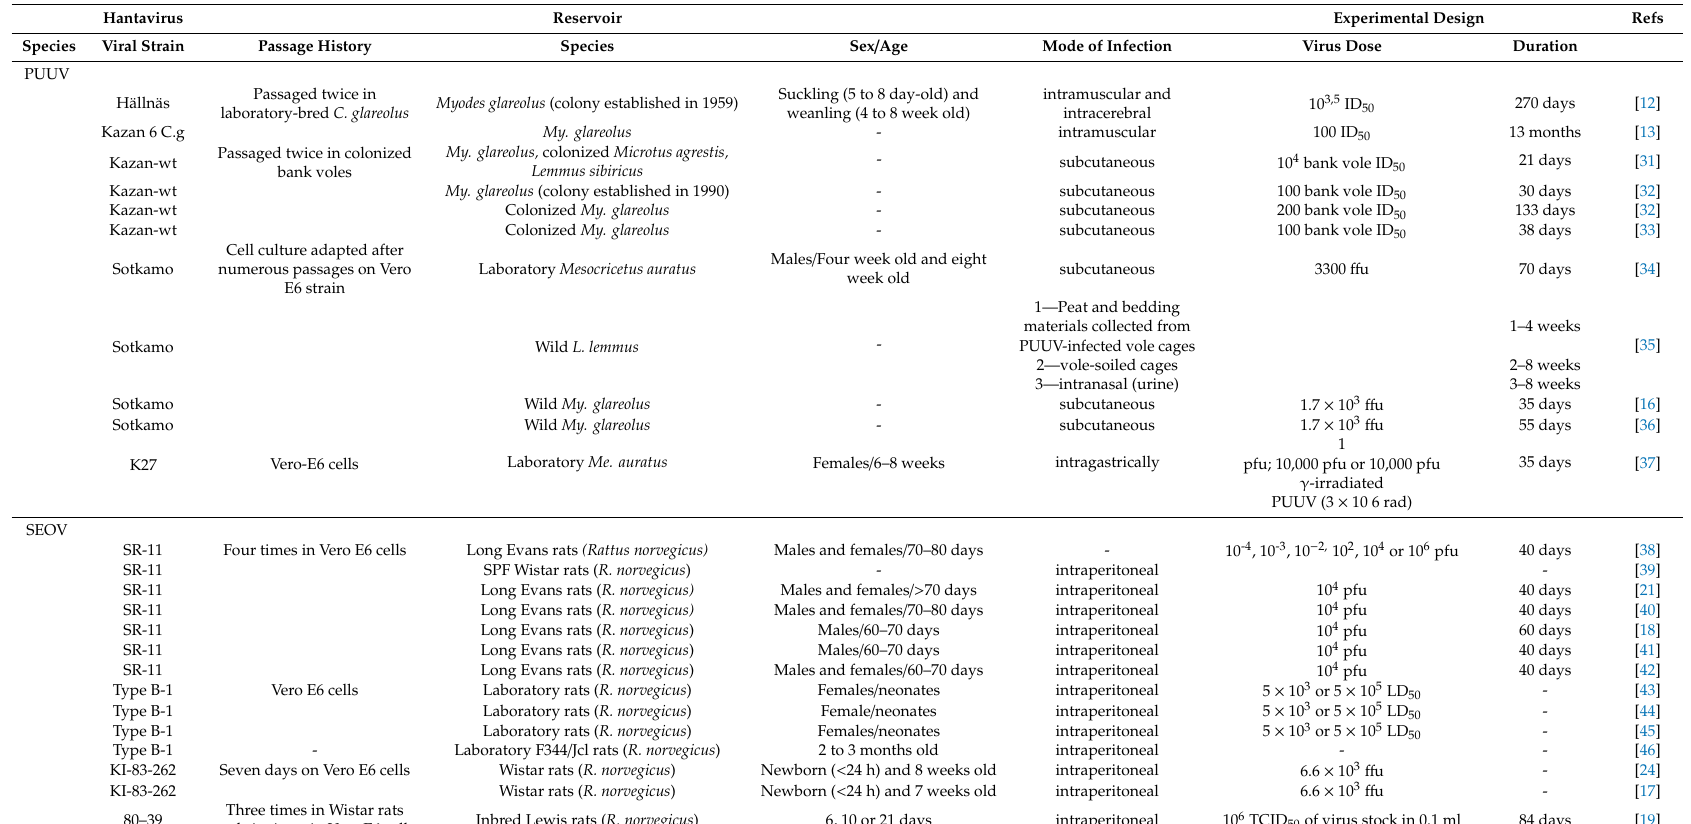
Table 1. Summary of hantavirus species, reservoirs and experimental protocols used in experimental infection carried out to study hantavirus / reservoir interactions in (a) laboratory and (b) environmental